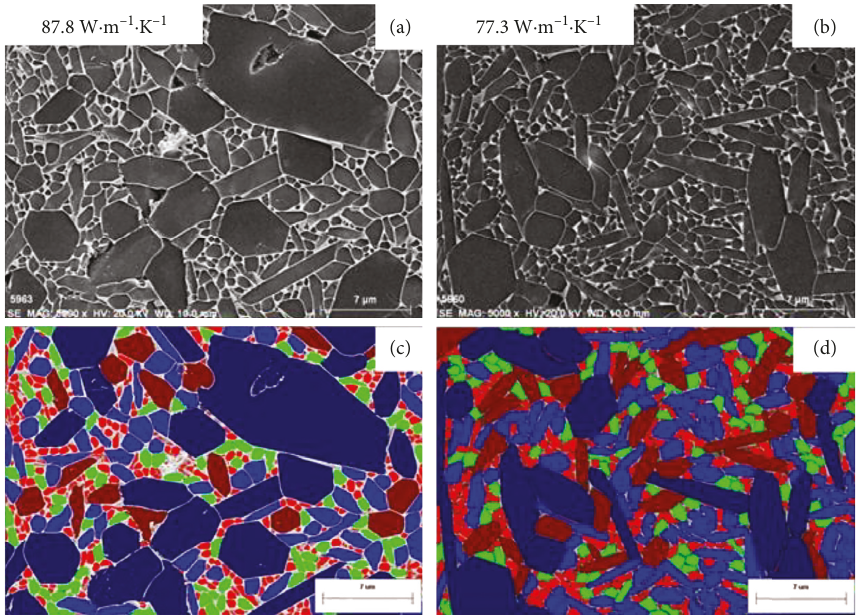
Figure 3: SEM micrographs ((a) Ac and (b) Af) and image analysis ((c) Ac and (d) Af) of the SRBSN.